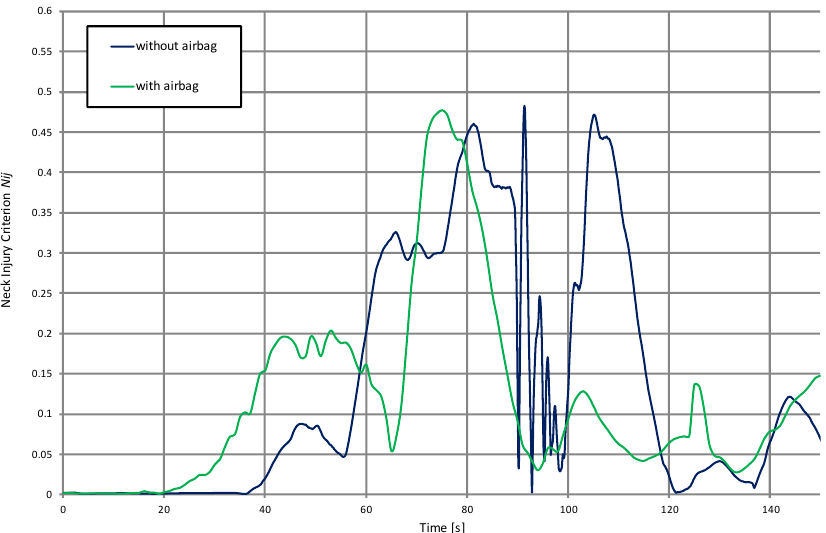
Figure 10. Neck injury criterion (Nij) for the case with and without the activated airbag.